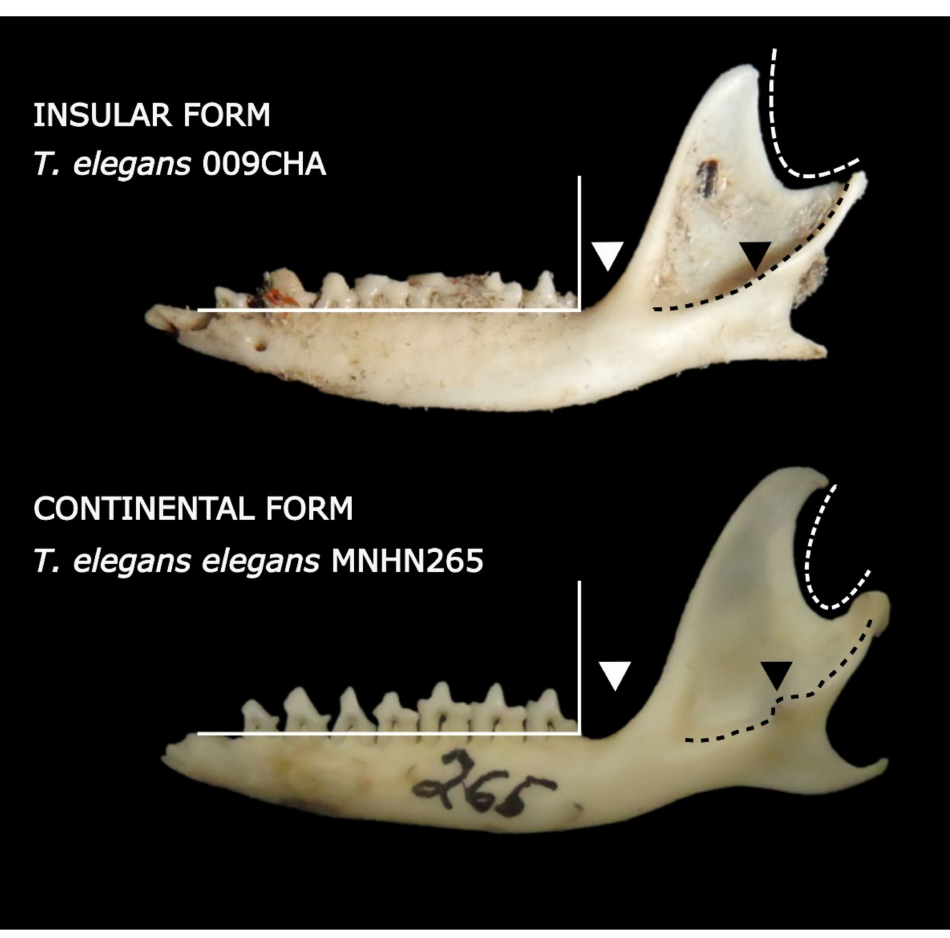
Figure 4. Comparison of representative mandibles of insular ( top ) and continental ( bottom ) popula- tions of Thylamys elegans . Morphological features: white triangle: retromolar fossa; black triangle: masseteric tuberosity. Continuous white lines are perpendicular to the molar line, and black seg- mented lines show the ventral border of the masseteric fossa, while the segmented white lines showcase the curvature between the coronoid process and the angular